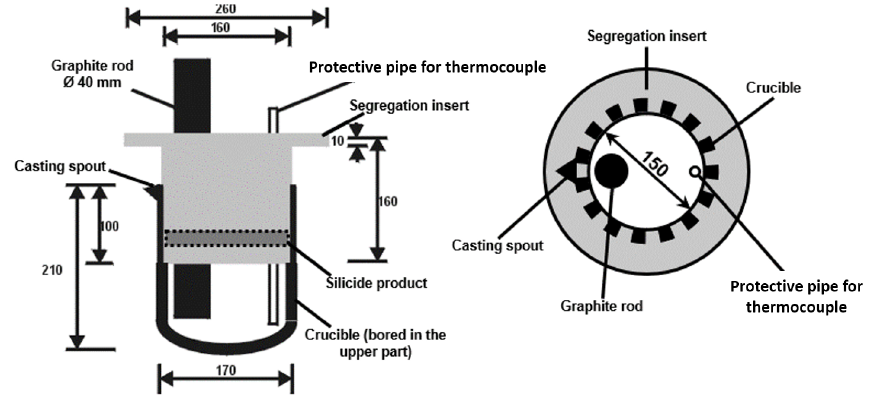
Figure 4. Segregation insert for the separation of silicide product and PbSn composite melt.